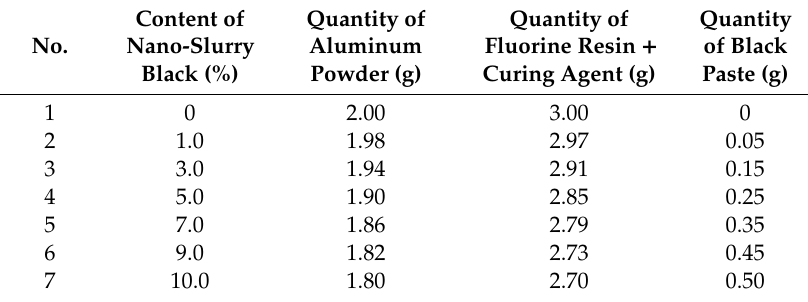
Table 1. Composition of di ff erent